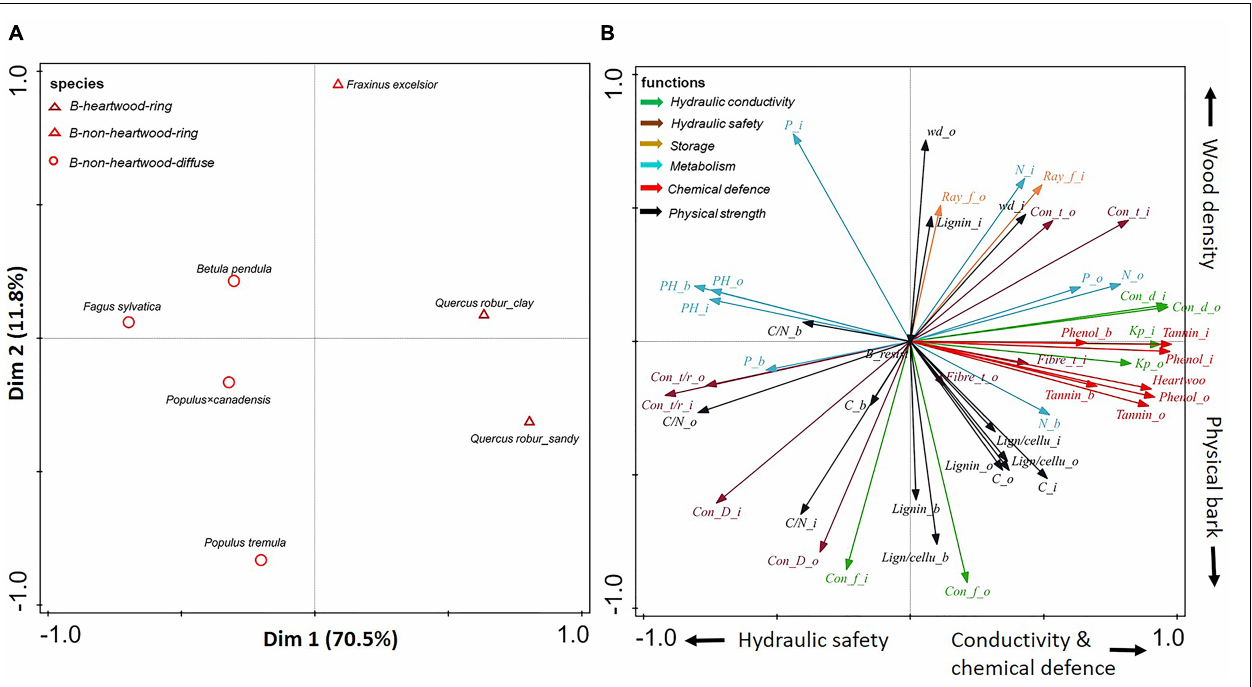
FIGURE 4 | (A,B) Principal-component analysis based on stem traits assessed in three compartments (inner wood, outer wood, and bark) for six angiosperms. Dark red triangles show ring-porous angiosperm species with heartwood; light red triangles show ring-porous angiosperm species without heartwood; light red circles show diffuse-porous angiosperm species without heartwood. The traits (indicated with arrows) are grouped according to six functions: hydraulic conductivity (in green), hydraulic safety (in dark brown), storage (in light brown), metabolism (in blue), chemical defense (in red), and physical strength (in black). For trait abbreviations, see Supplementary Table 2